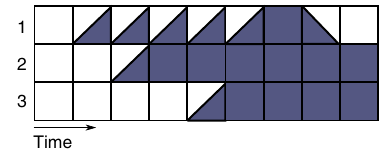
Fig. 4 One of the possible executions using the Most Permissive semantics on the BN in Fig. 2(b). The execution starts from the con fi guration where all components are inactive. Note that it correctly recovers the (transient) reachability of the con fi guration where the three components are